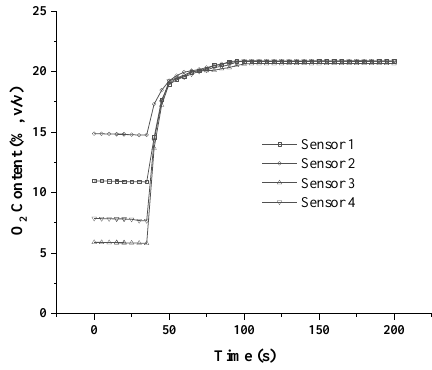
Figure 4. Equilibrium time of the oxygen-concentration monitoring equipment in air.